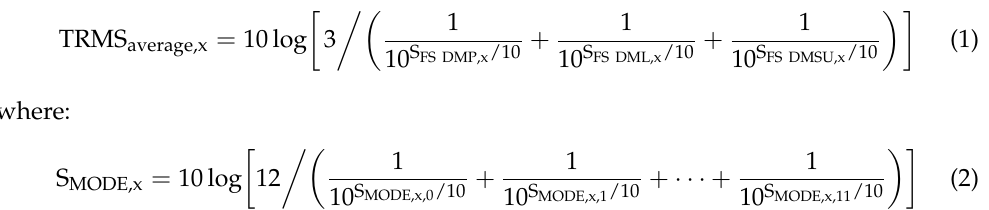
Table 2. A summarization of the MIMO OTA testing setup. Parameters Experimental Setup DUTs 10 Smartphones Test Methodology MPAC (reference) MIMO 2 × 2 Band Band 5 (881.5 MHz) Environmental Condition UE Noise-Limited & Interference-Limited DUT Placement Black Box FoMs TRMS &MARSS Outage Levels 95%/90%/70% Channel Models SCME UMa